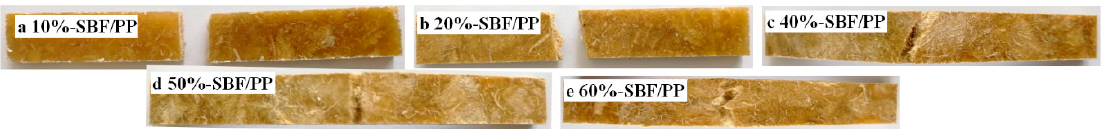
Figure 5. Photograph of the composites after the impact test. ( a – e ) belong to the composites with 10%– 60% SBF,